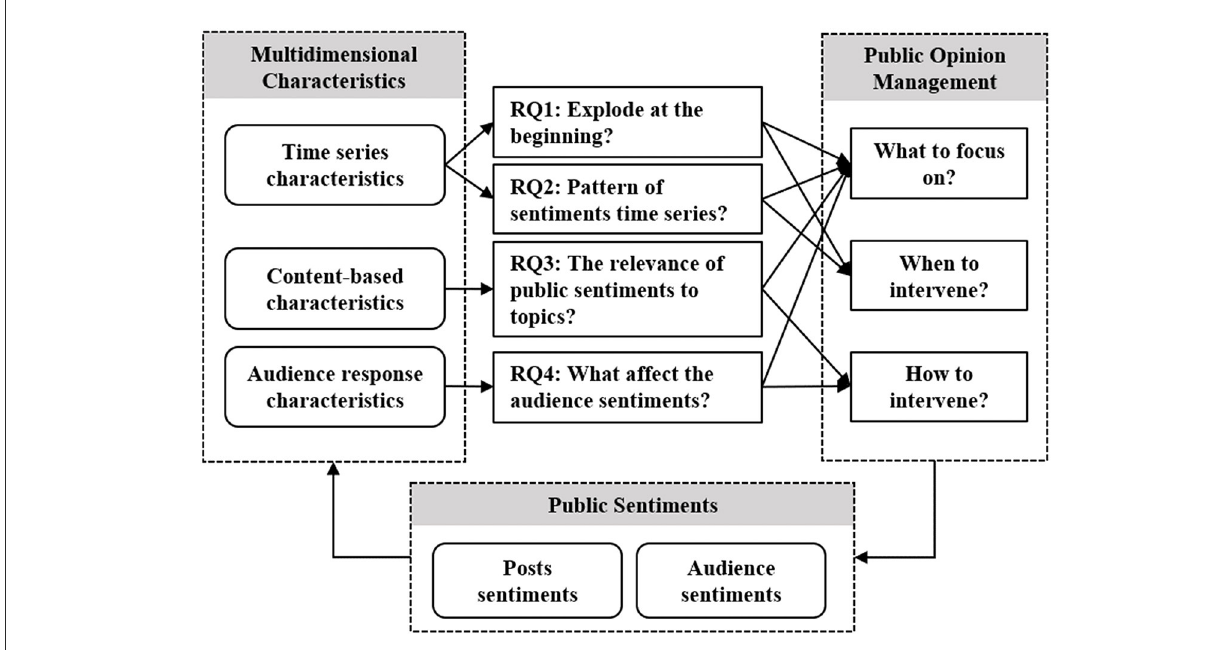
FIGURE1 The multidimensional characteristics of public sentiments in public opinions management during the public emergencies.